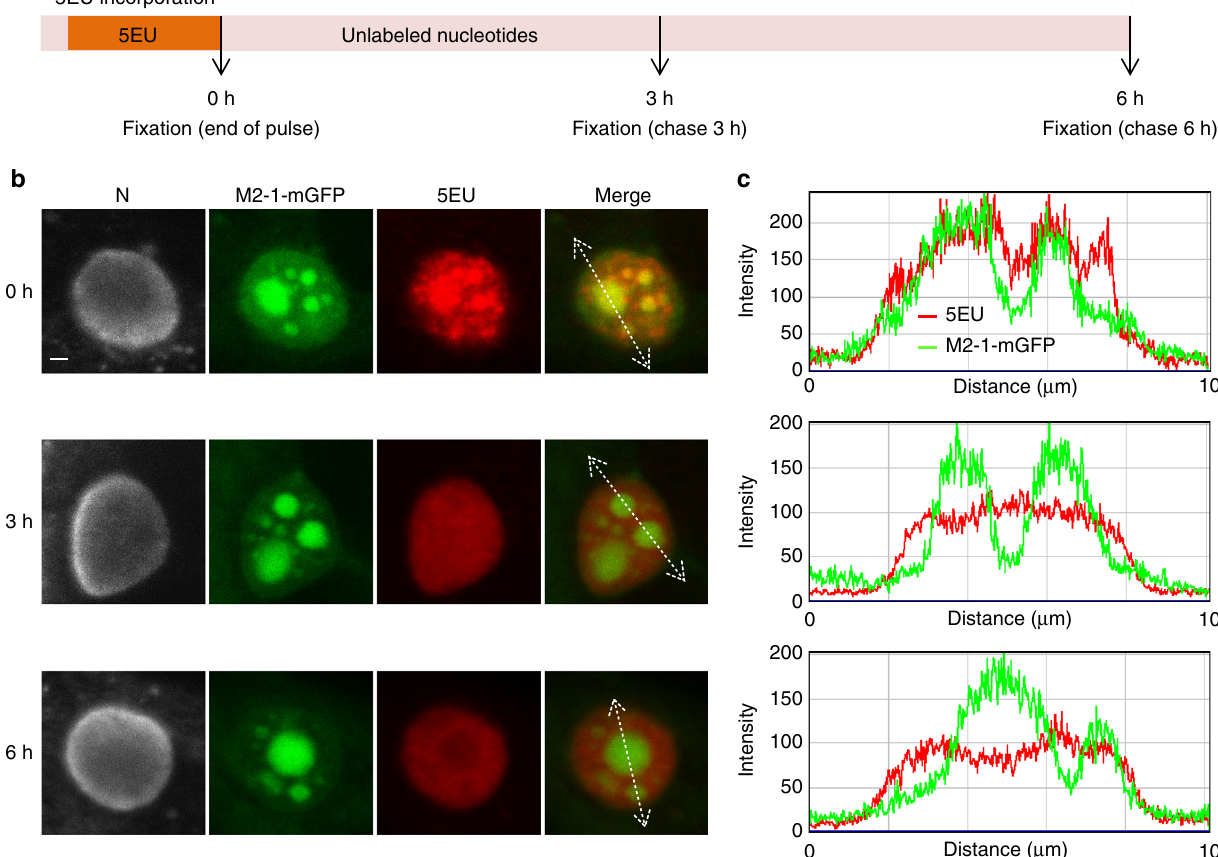
Fig 7 Concentration of newly synthesized viral RNAs in IBAGs is transient. a Schematic time line of the pulse chase experiments. HEp-2 cells were infected with RSV-M2-1mGFP. At 24 h p.i. cells were incubated for 1 h with actinomycin D to inhibit cellular transcription and 5-ethynyl uridine (5EU) was added for one more hour (pulse). Cells were rinsed and fi xed immediately (0 h) or after 3 or 6 h (chase). The 5EU incorporated in viral RNAs was detected using Alexa Fluor 647-azide ( red ) and cells were stained with an anti-N antibody ( gray ) and Hoechst 33258 (merge). The M2-1mGFP protein is visualized through its spontaneous green fl uorescence. b Representative pictures from four independent experiments are shown. Images of inclusion bodies taken under a Leica SP8 confocal microscope at 0, 3 and 6 h after the 5EU pulse are presented. Scale bar 1 µ m. The white lines indicate the track of a line intensity pro fi le across the IBs